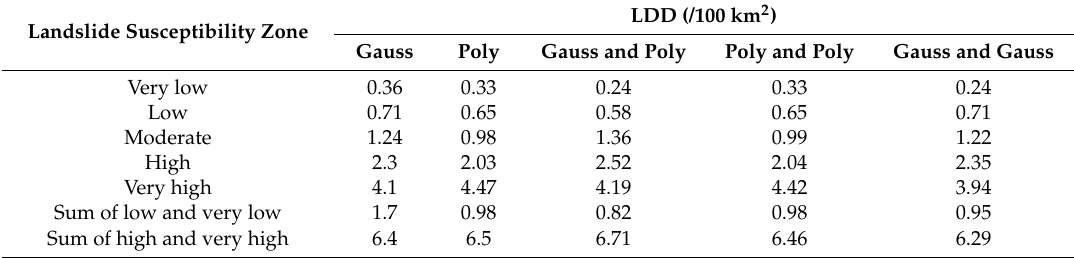
Table 3. The landslide dot densities of the five landslide susceptibility zones. LDD, landslide dot